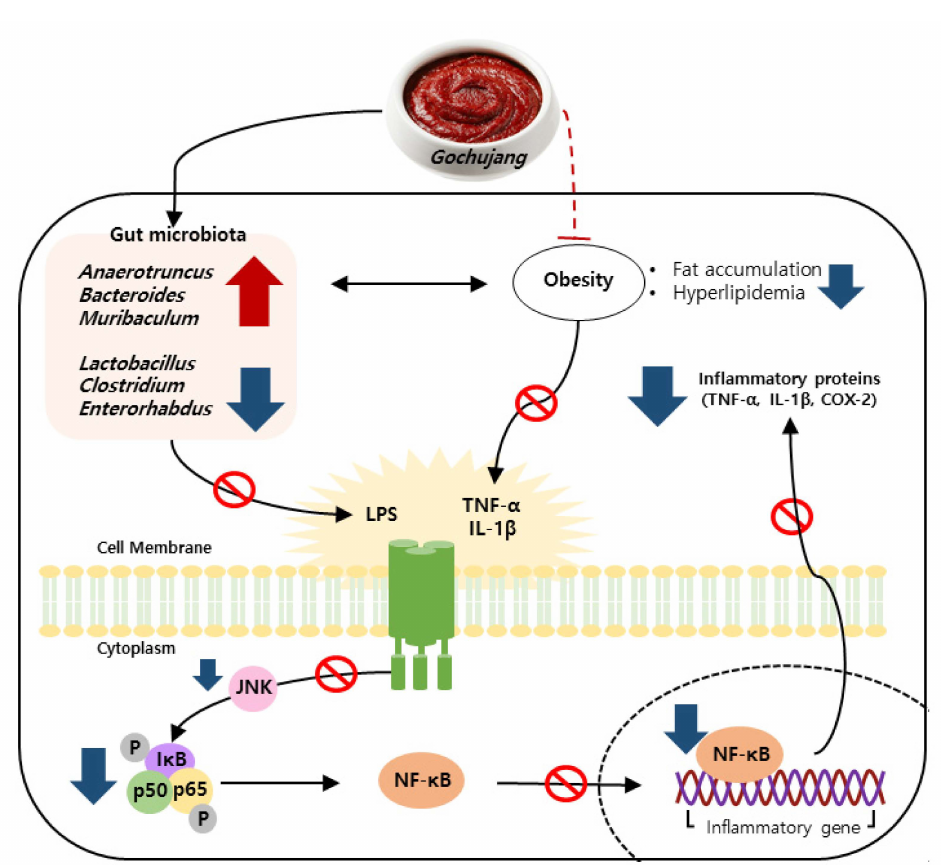
Figure 10. Schematic depiction of the anti-hepatic inflammatory mechanism of Gochujang in HD induced obese